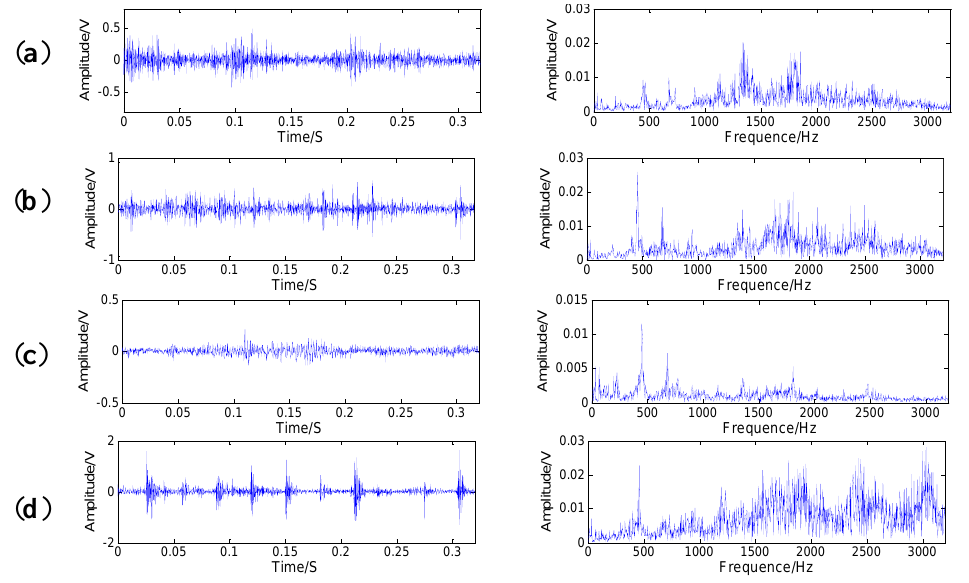
Figure 14. Original time waveforms and their corresponding spectrums of sun gears in four conditions: ( a ) cracked tooth; ( b ) pitted tooth; ( b ) chipped tooth; ( c ) missing